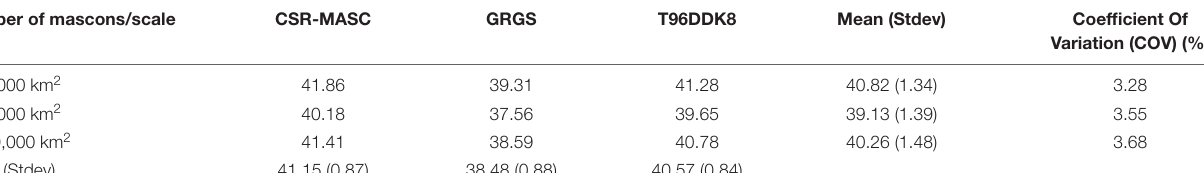
TABLE 4 | Total mass loss estimated using to the three GRACE TWS solutions and the three mascon delineations in Gt/year ( Figure 2 ).